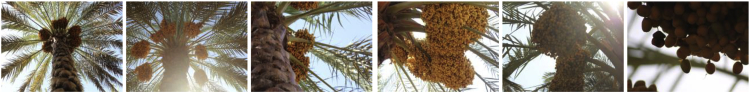
Sample images of the dataset-1 showing large variation in scales, angles, and illumination.